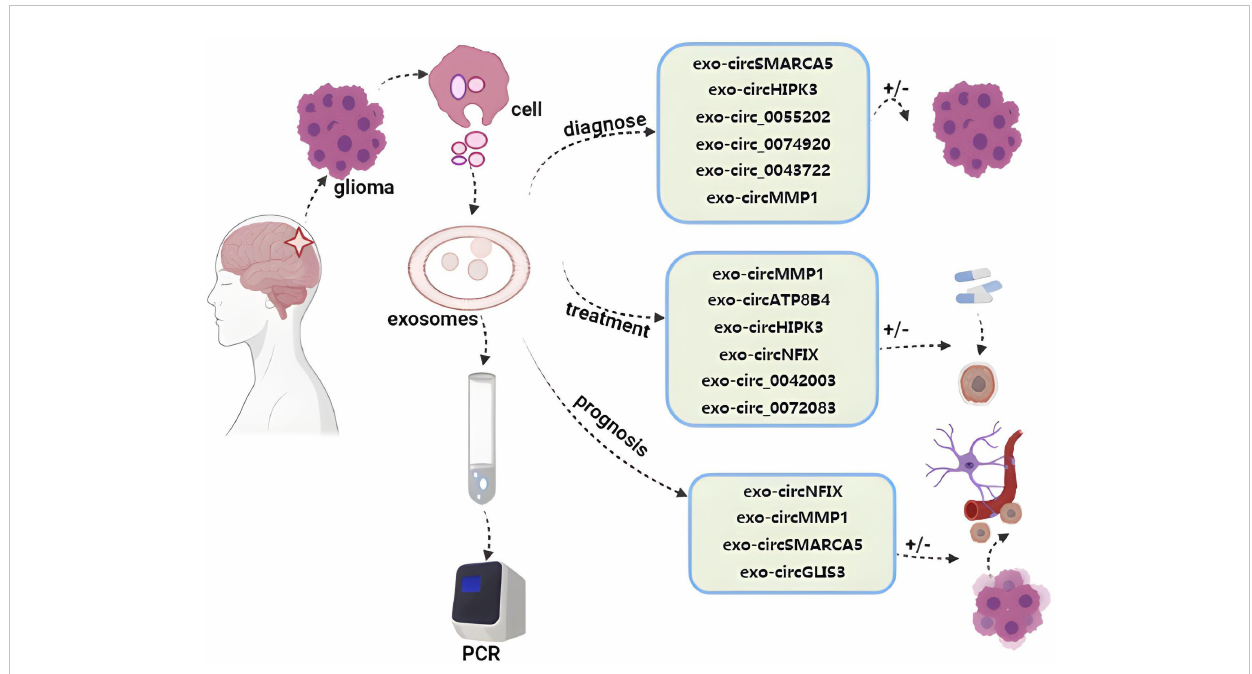
FIGURE 3 Roles of exosome circRNAs in liquid biopsy for glioma. By detecting exosomal circRNAs evaluating diagnosis, treatment, and prognosis of glioma (29, 30, 97, 98, 103, 107, 109, 113 – 115, 117,